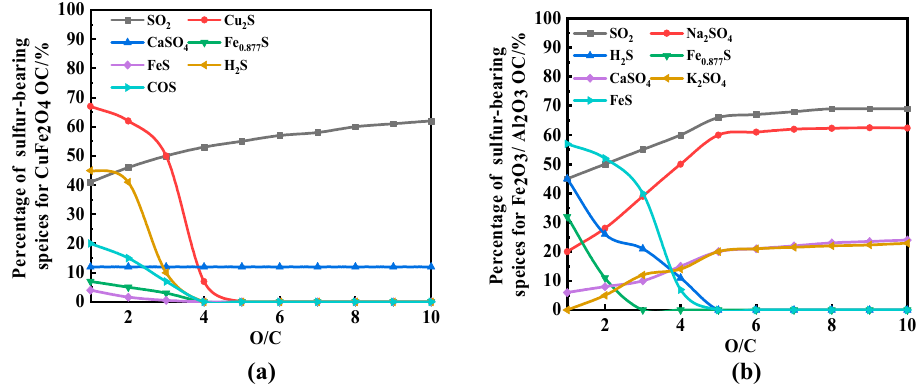
Figure 2. The variation trend of sulfur-containing substances during coal CLC with ( a ) CuFe 2 O 4 and ( b ) Fe 2 O 3 /Al 2 O 3 under different O/C.